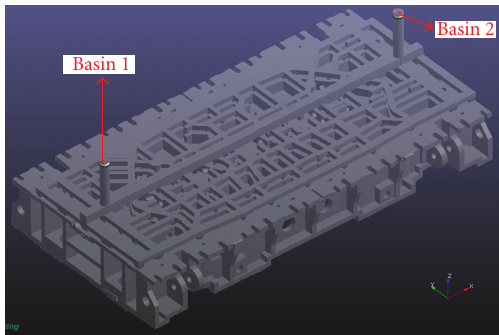
Figure 13: Presentation of the casting model with two basins.